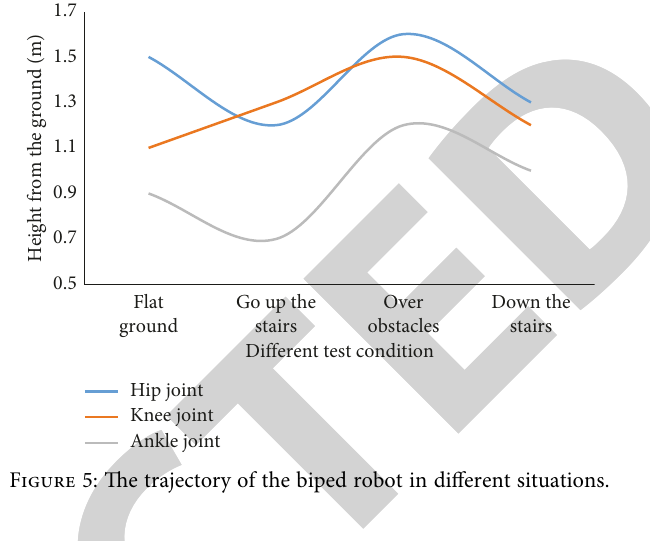
Figure 5: The trajectory of the biped robot in different situations.